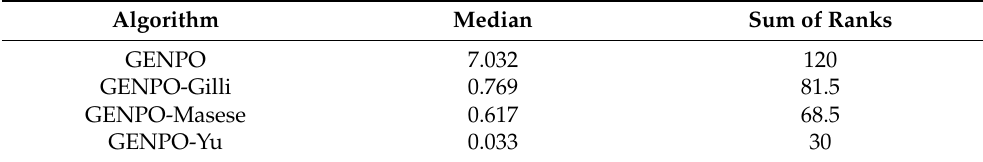
Table 8. Friedman Test Genetics Algorithms without MARR constraint.